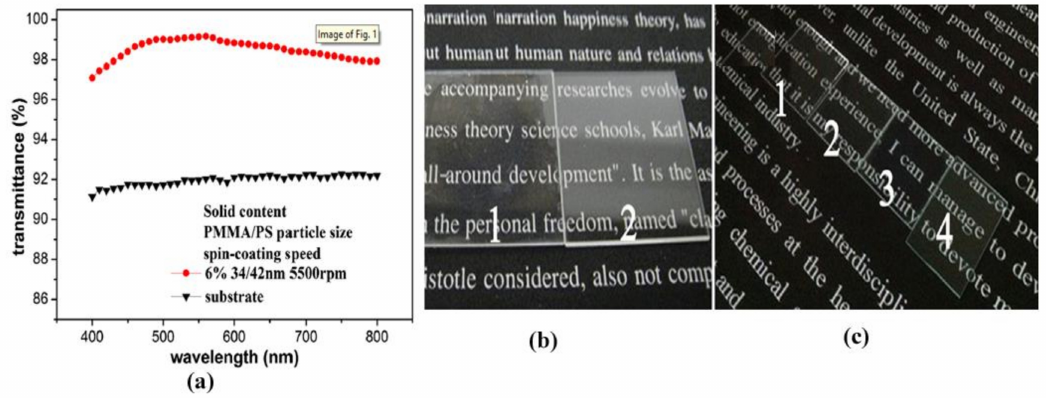
Figure 24. ( a ) Transmittance spectra of uncoated substrate and coated substrate in visible range ( b ) Images of substrate under bright light (1. Coated PMMA sheet; 2. bare PMMA sheet), ( c ) images of substrate under normal light (1. Uncoated PMMA sheet; 2. one-side coated PMMA sheet; 3. both sides coated PMMA sheet; 4. uncoated glass sheet). Reprinted with permission [213]; 2014,